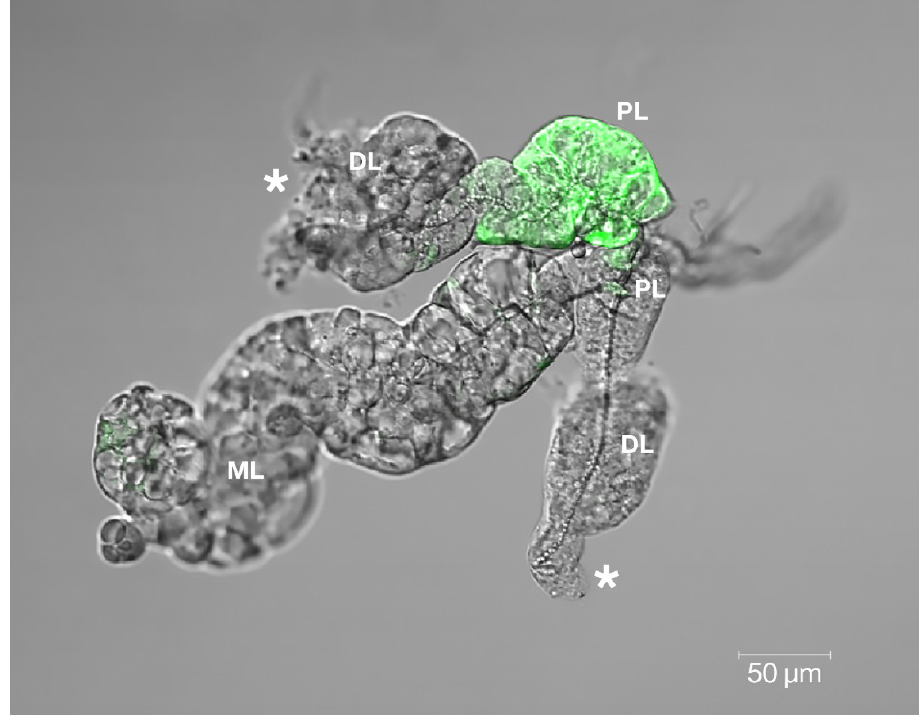
Figure 6. Confocal immunomicroscopy revealed SINVTaV-GFP-TC persistence localized in the SG proximal lateral lobe (PL) at day 30 p.i. on this whole-mounted specimen. Gross cytopathology ( * ) was observed in both distal lateral lobes (DL). Virus GFP was not detected in the median lobe (ML), which appeared intact and comparable to the uninfected control ML (Figure